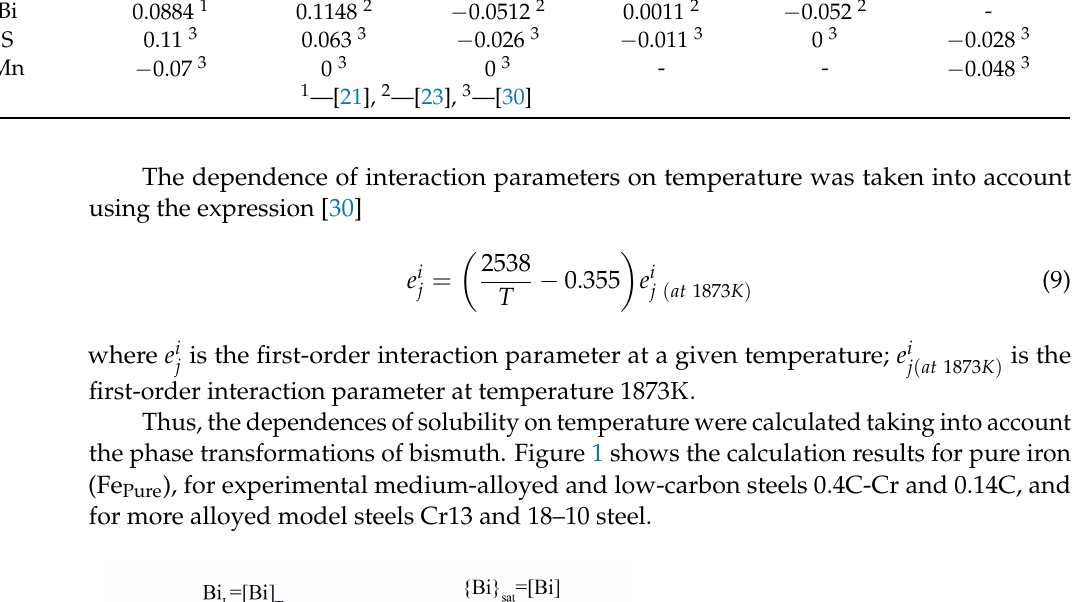
Table 2. First-order interaction parameters.